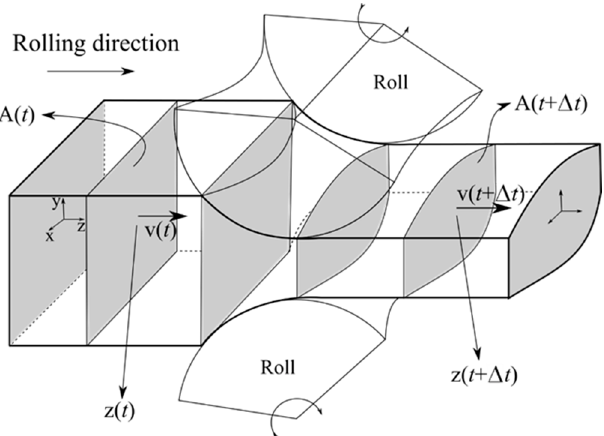
Figure 2. Scheme of the slice model and rolling layout. Area A , time t , position z , and velocity v , are calculated for each slice.